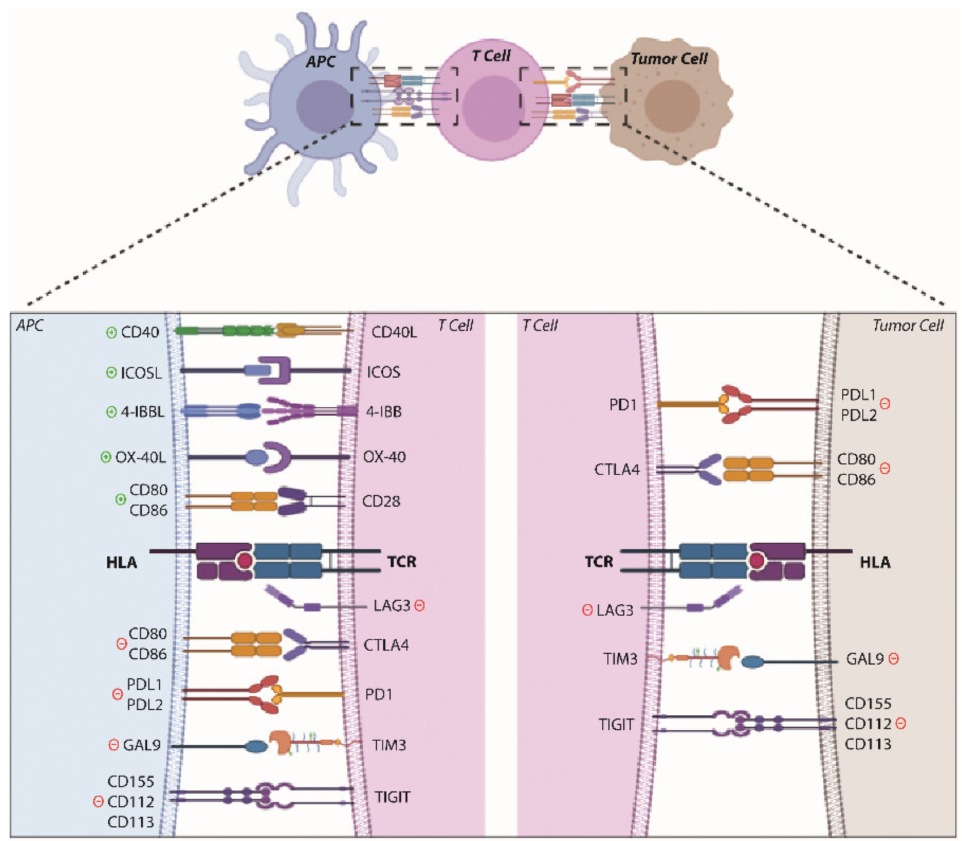
Figure 1. Scheme of co-stimulatory and co-inhibitory receptors implicated in the immune response. Created using